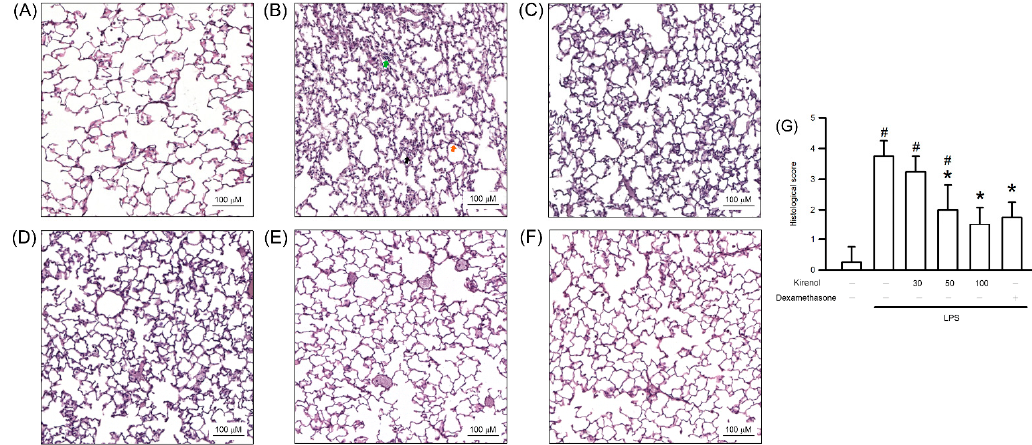
Figure 1. Kirenol protected against histopathological changes in lung tissues in lipopolysaccharide (LPS)-induced Acute lung injury (ALI) mice. ( A ) Control group also named Group I; ( B ) LPS group also named Group II; ( C ) 30 mg/kg kirenol + LPS group also named Group III; ( D ) 50 mg/kg kirenol + LPS group also named Group IV; ( E ) 100 mg/kg kirenol + LPS group also named Group V; ( F ) 1 mg/kg dexamethasone + LPS group also named Group VI. Histopathological changes were observed using Hematoxylin-eosin staining of lung sections under light microscopy. The magnification of the enlargements are 100 times. The scale bars represent 100 µ m. Green arrow indicates neutrophil infiltration; black arrow indicates hyaline membrane formation; orange arrow indicates alveolar wall thickness. ( G ) The histologic scores are presented for the lung tissues. Values are shown the mean ± S.D. of 3–4 mice per group. # represents the significant difference compared with the Group I ( p < 0.05); * represents the significant difference compared with the Group II ( p < 0.05).